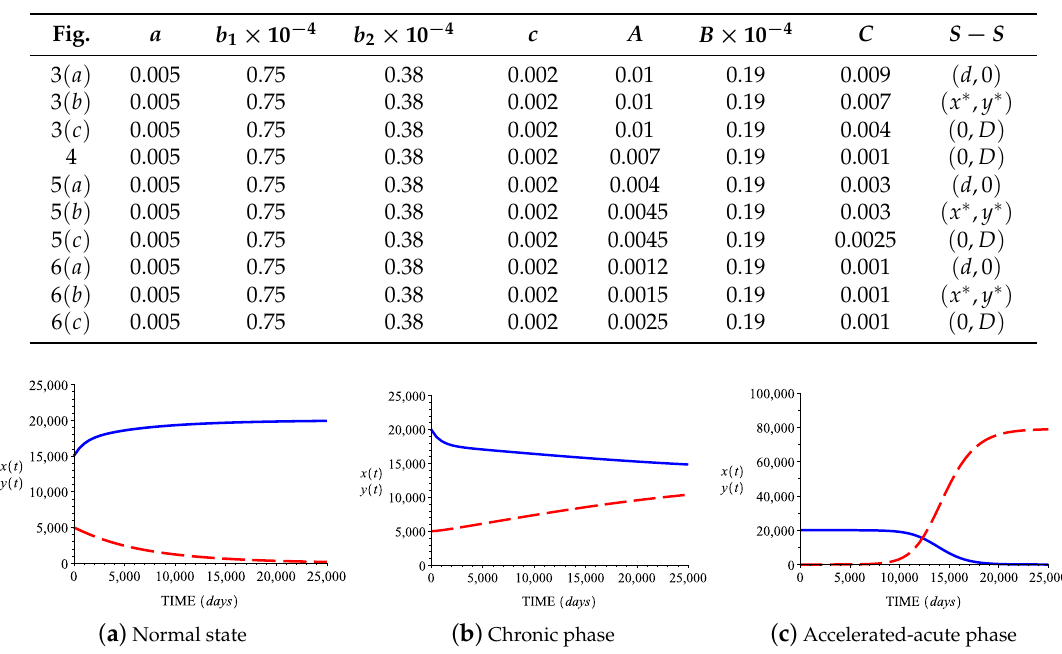
Table 2. Parameter values for simulations. S-S = steady state; d = 2 × 10 4 (normal); D = variable parameter (leukemic).